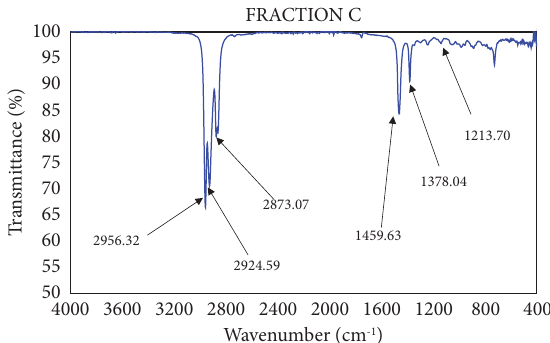
Figure 12: FTIR spectrum of fraction C from the ethanol extract of C. nioroense .